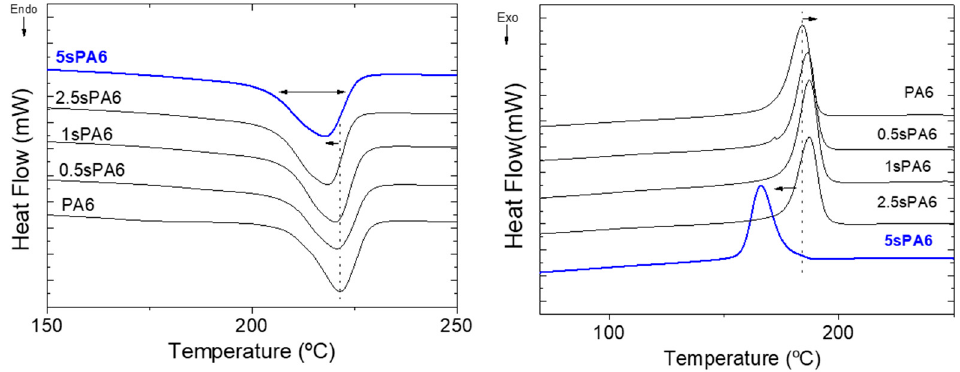
Figure 5. DSC thermograms of the star-branched polyamides’ ( left ) melting and ( right ) crystallization curves.